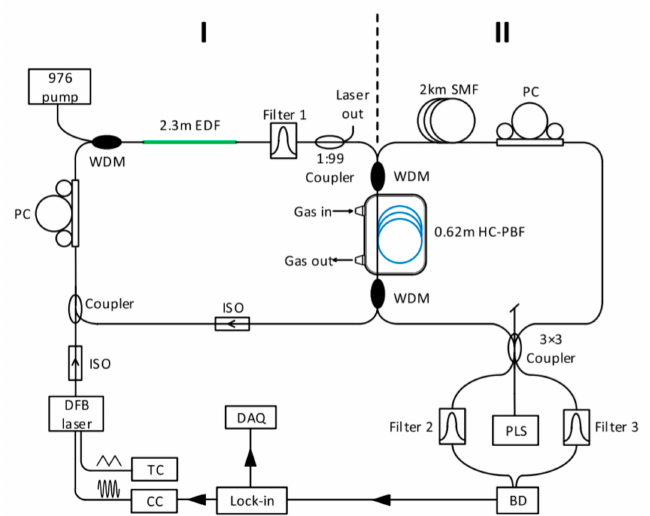
Figure11. ExperimentalsetupoftheintracavityPTgassensor. TC—temperaturecontroller, CC—current controller, DAQ—data acquisition, EDF—erbium-doped fiber, WDM—wavelength division multiplexer, ISO—optical isolator, PLS—probe light source, HC-PBF IC—hollow core photonic bandgap fiber gas cell, BD—balanced detector, PC—polarization controller. Reprinted with permission from [56] C The